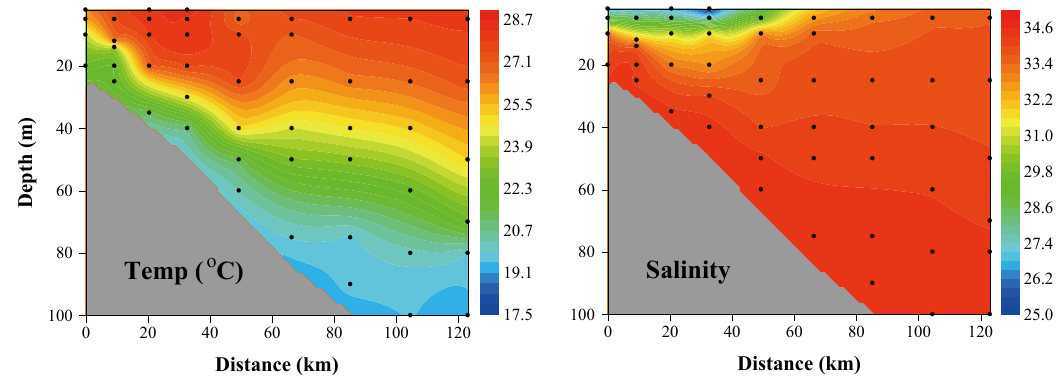
Fig. 3. Temperature ( ◦ C) and salinity at the cross-shelf transect 2 on the northern South China Sea